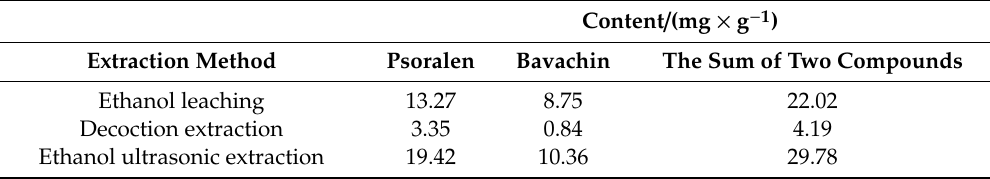
Table 1. E ff ects of di ff erent extraction methods on the levels of psoralen and bavachin within total extracts of Psorslea corylifolia L. ( n =